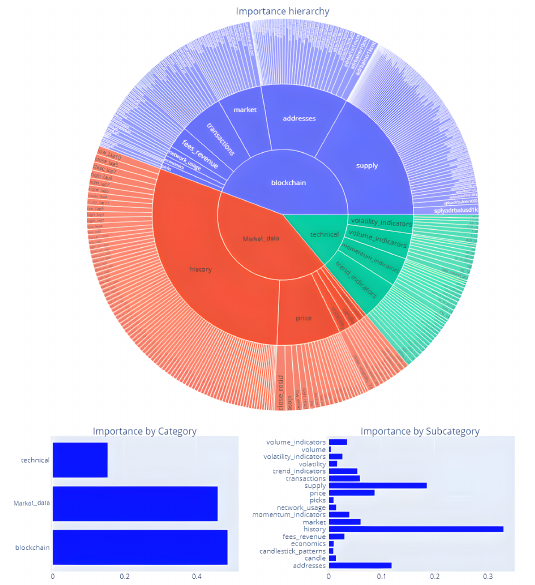
Figure 2. Hierarchical mean feature importance over all the analyzed